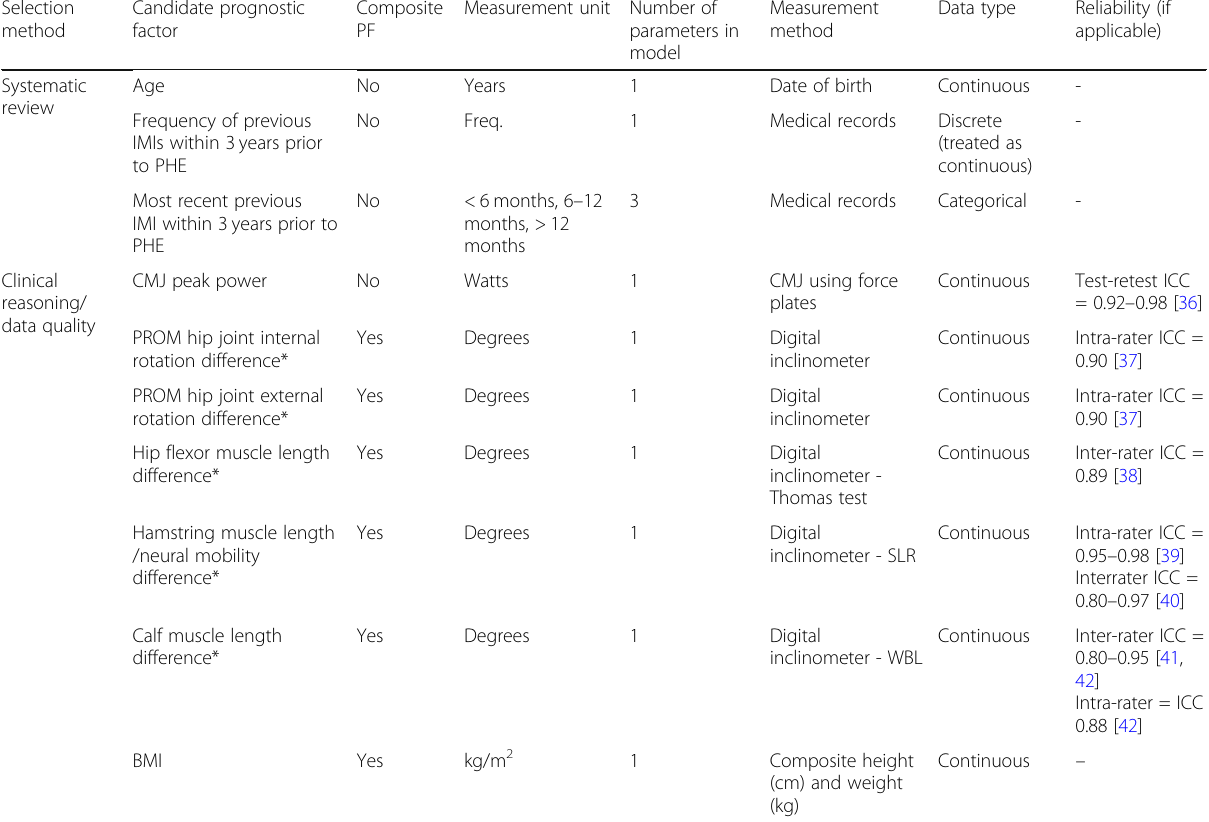
Table 3 Restricted set of candidate prognostic factors for model development and validation Selection